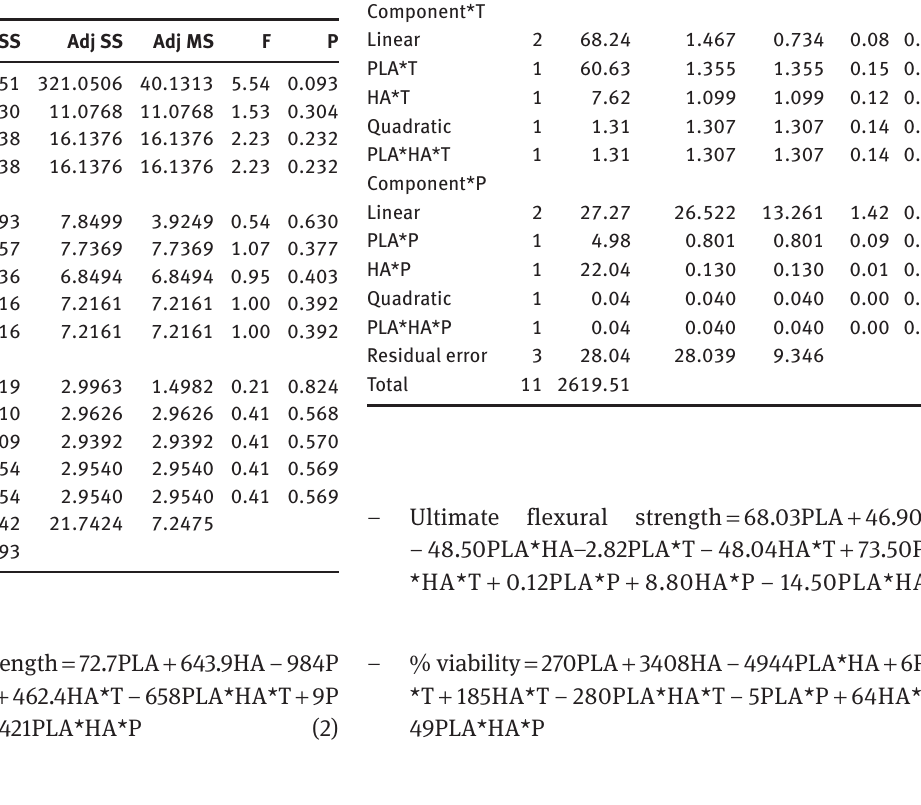
Table 10: Variance analysis of tensile strength.